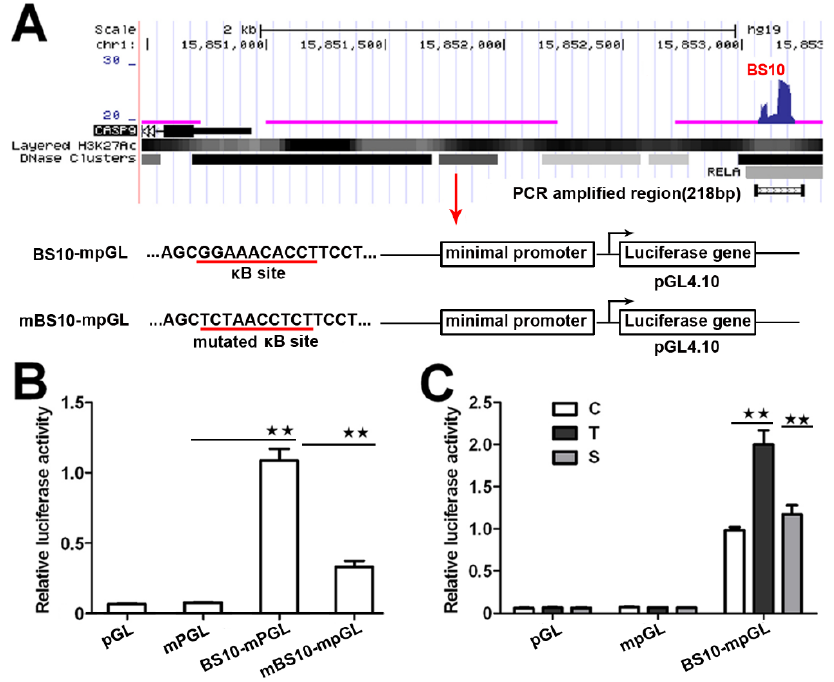
Figure 2. Transcriptional activity of NF- κ B-BSs assigned to CASP9 . ( A ) Schematic showing the